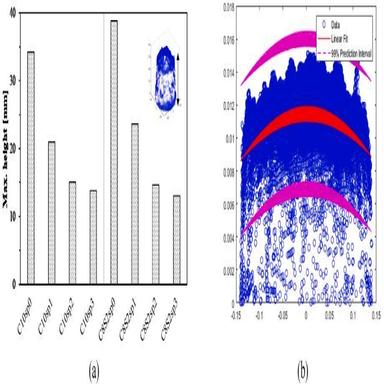
Point cloud-based analysis of the mini-slump flow: (a) maximum height and (b) curvature.